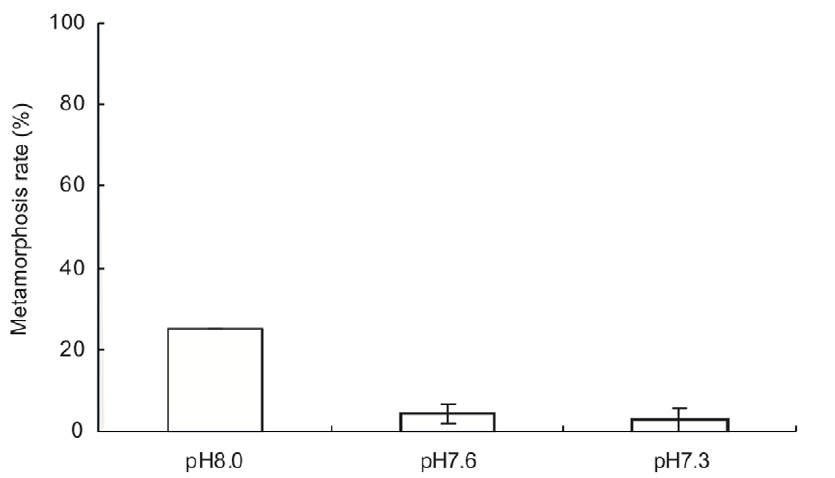
Figure 5. Metamorphosis rate of larvae of Acroporadigitifera after seven-day exposure to three different pH conditions. Bars indicate means and standard errors ( n